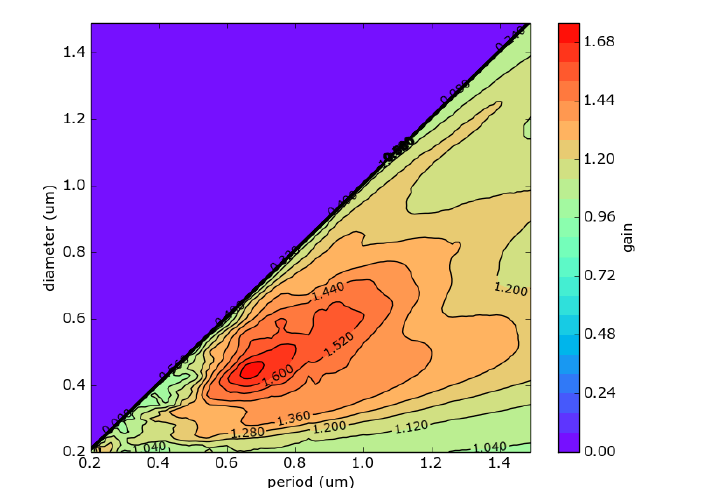
Figure 10. PhC slab optimization over the parameters period and diameter. The fixed parameters are: pillar shape, height = 300 nm, hexagonal placing and air coupling